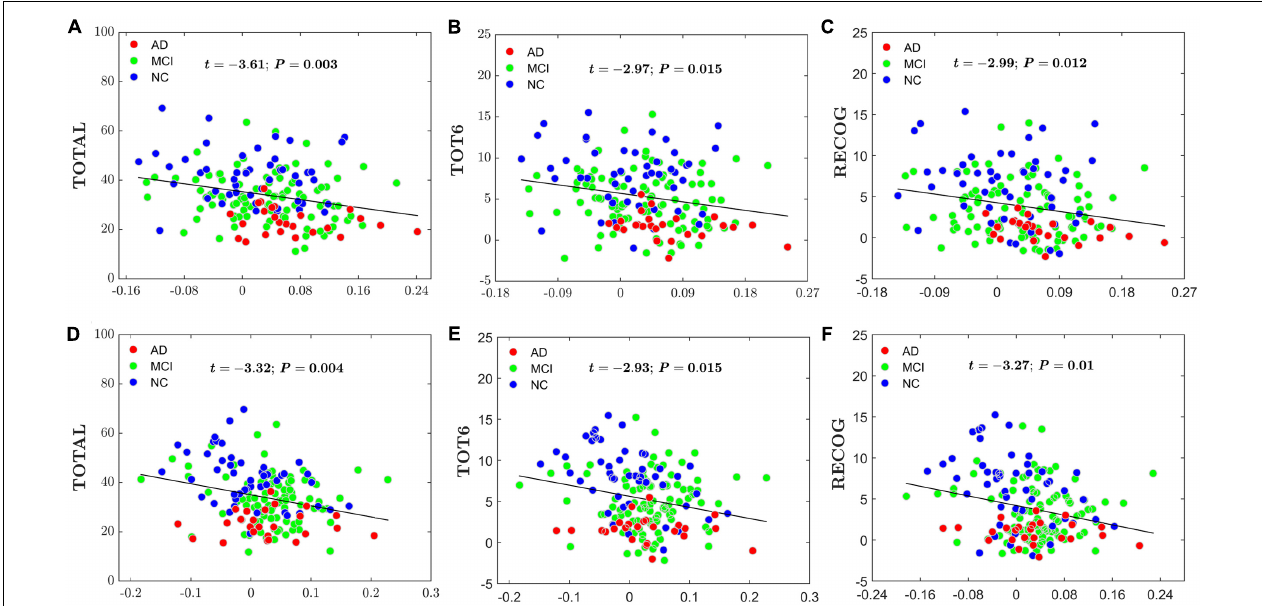
FIGURE 9 | Scatter plots of the AI of the nodal efficiency and RAVLT-related scores. The red circles represent AD patients; the green circles represent MCI patients; the blue circles represent NC subjects. (A) The significant correlations between the AI of the nodal efficiency and TOTAL in AFG. (B) The significant correlations between the AI of the nodal efficiency and TOT6 in AFG. (C) The significant correlations between the AI of the nodal efficiency and RECOG in AFG. (D) The significant correlations between the AI of the nodal efficiency and TOTAL in CUN. (E) The significant correlations between the AI of the nodal efficiency and TOT6 in CUN. (F) The significant correlations between the AI of the nodal efficiency and RECOG in CUN.